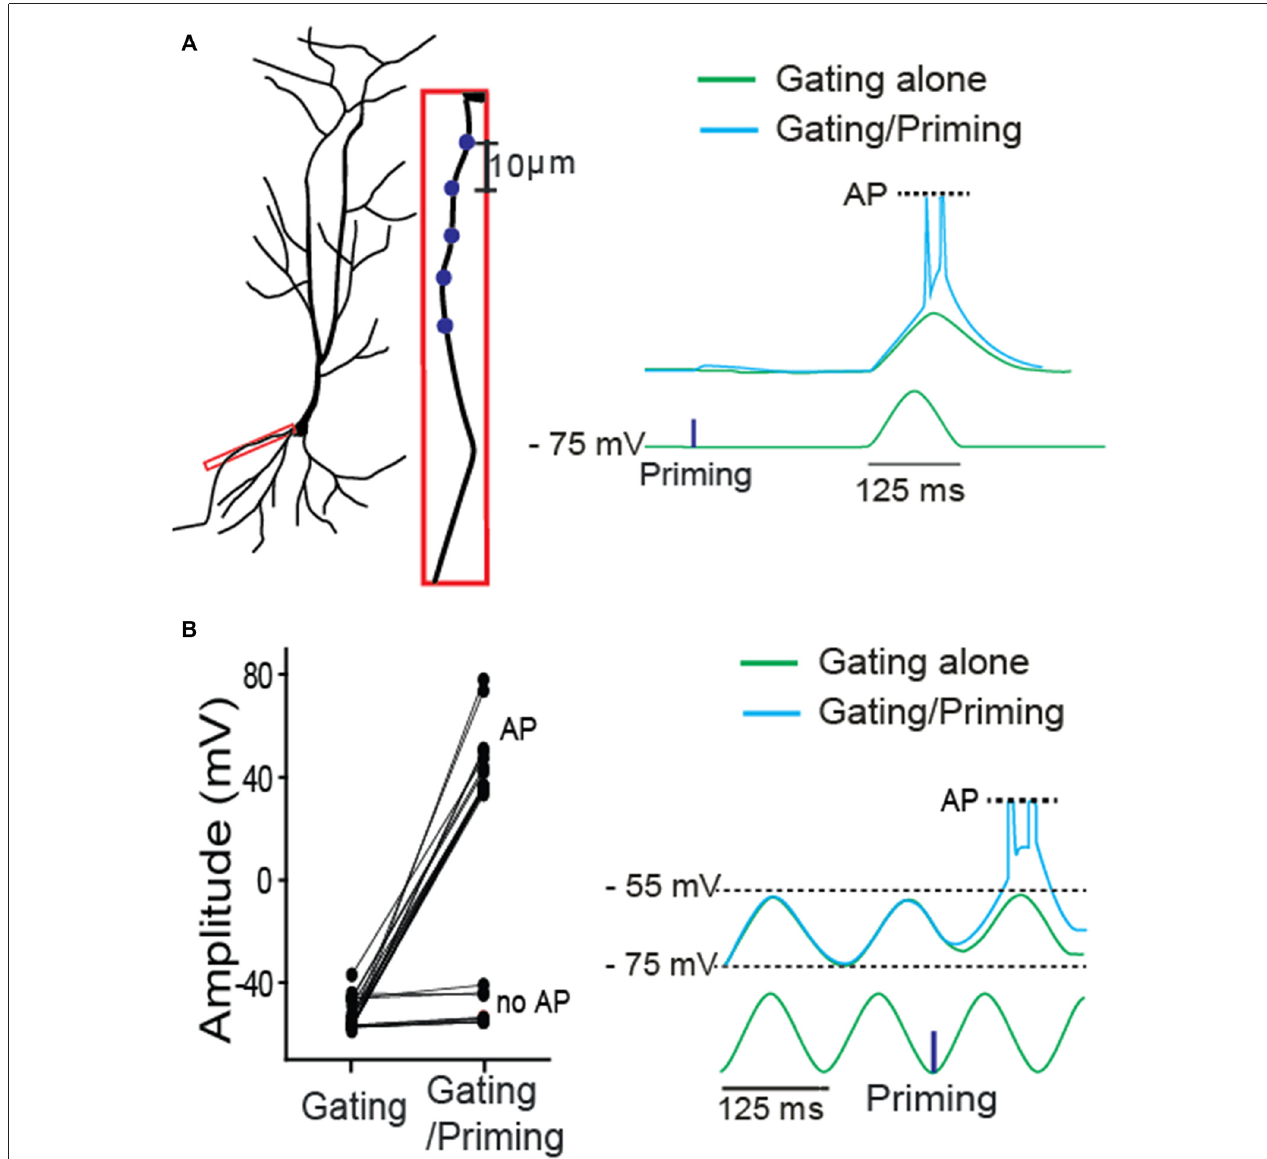
FIGURE 3 | A role of intrinsic membrane excitability as a gating signal in STPP. (A) Blue dots for priming photostimulation were positioned in a basal dendrite. The read-out action potentials (APs) were observed only when intrinsic excitability was combined with the prepositioned priming photolysis. Blue dots for priming photostimulation were located in a basal dendrite. (B) ∼ 8 Hz oscillatory sinusoidal wave elicited by current injection triggered APs only when the peak was preceded by a priming signal (uncaging). The all-or-none APs were shown with 71% success rate (AP: n = 17; no AP: n =